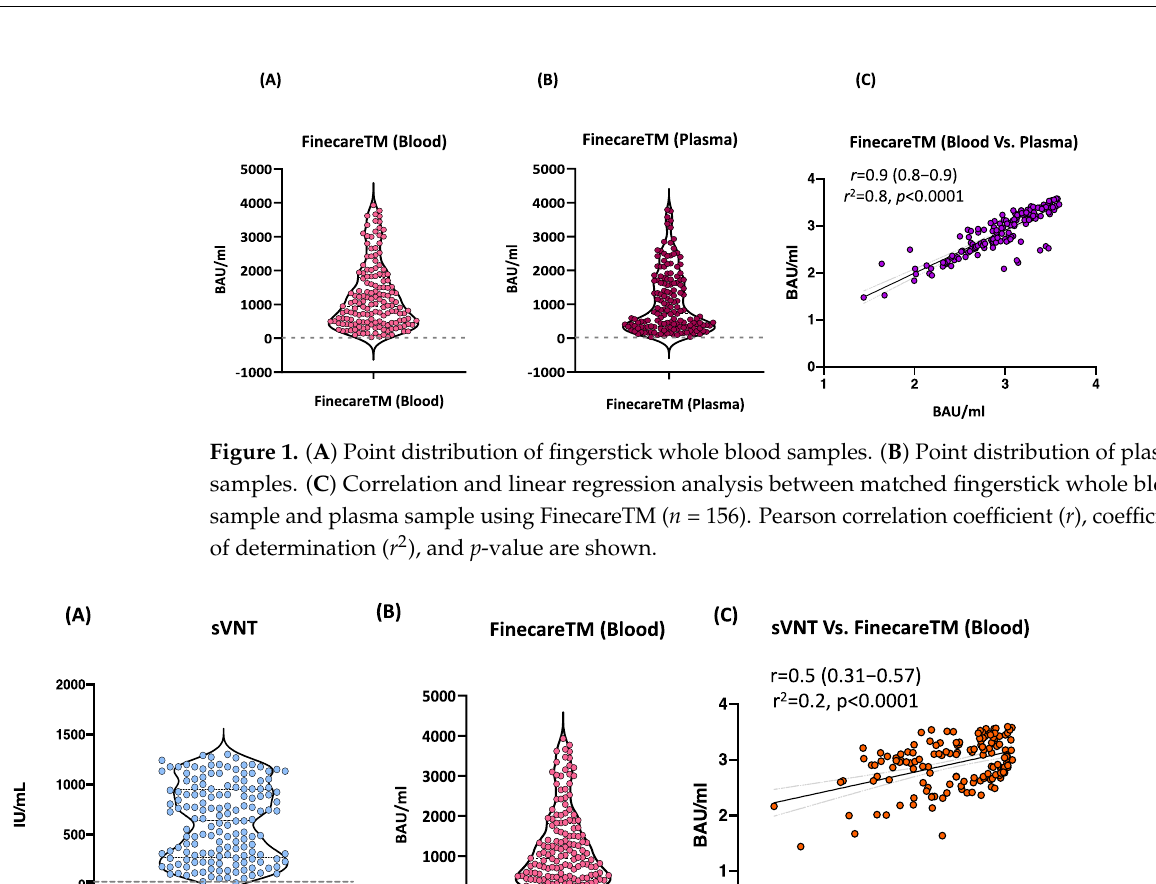
Figure 1. ( A ) Point distribution of fingerstick whole blood samples. ( B ) Point distribution of plasma samples. ( C ) Correlation and linear regression analysis between matched fingerstick whole blood sample and plasma sample using FinecareTM ( n = 156). Pearson correlation coefficient ( r ), coeffi- cient of determination (R 2 ) , and p -value are shown.